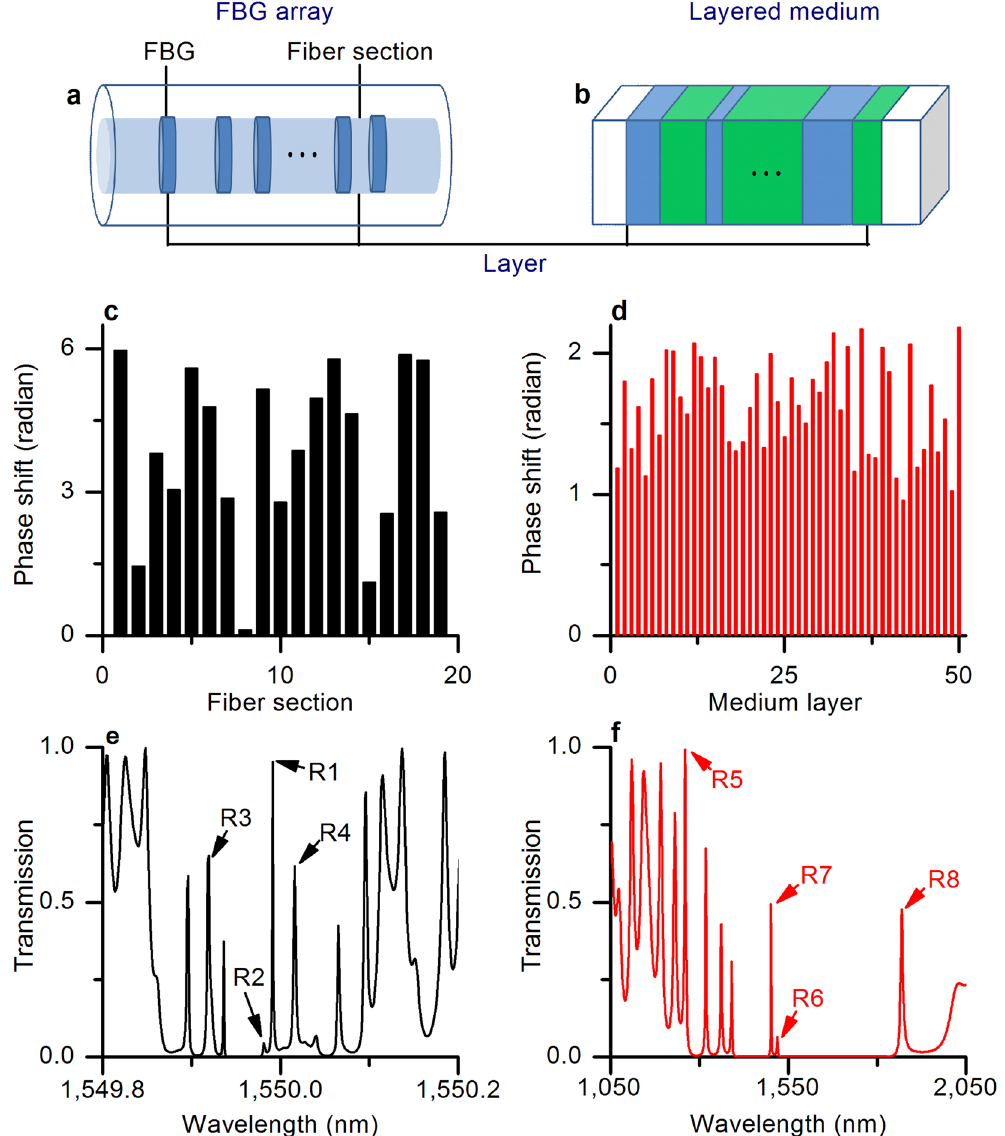
Figure 1. Disordered mediums and disorder-induced resonant transmissions. ( a ) FBG array; ( b ) layered medium. Random phase shifts in ( c ) the FBG array, and ( d ) the layered medium. Disorder-induced resonant transmissions in ( e ) the FBG array, and ( f ) the layered